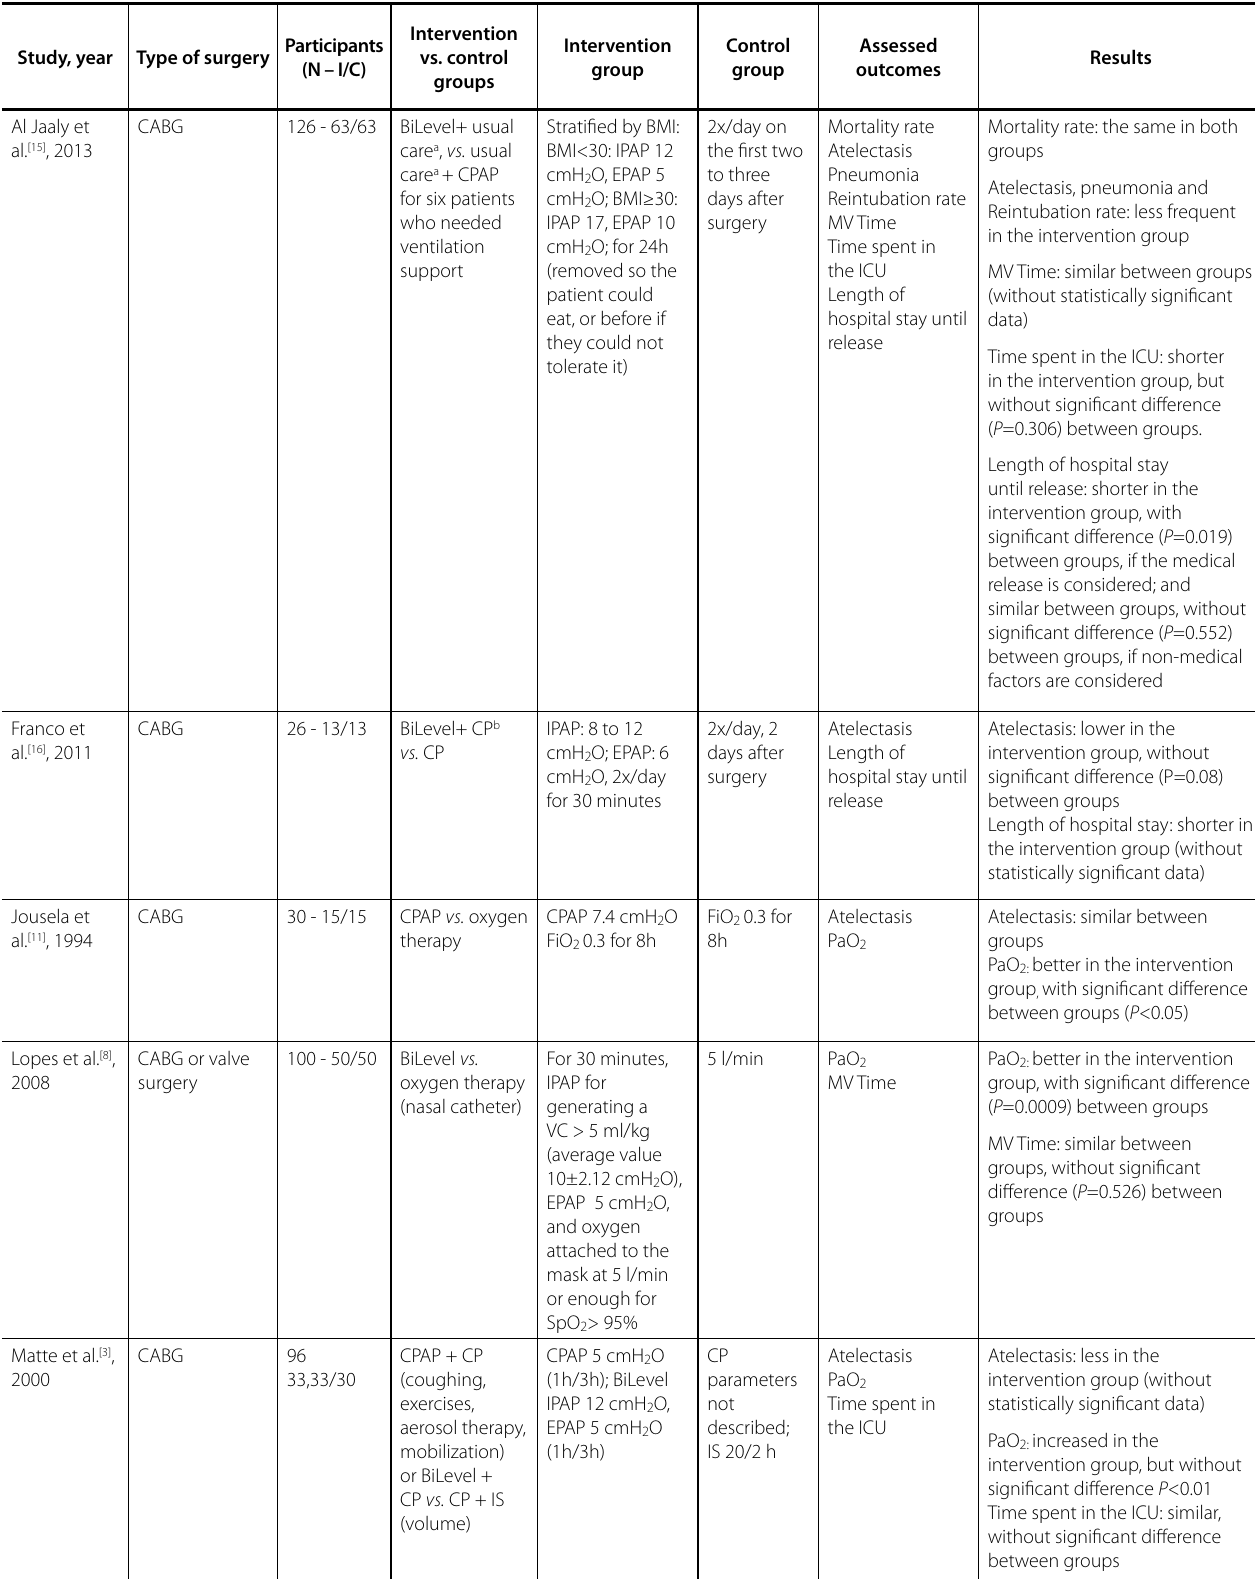
Table 2. Characteristics of the studies included in the review. Study, year Type of surgery